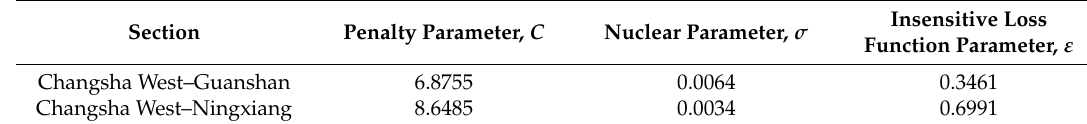
Table 4. Optimization of parameter values.